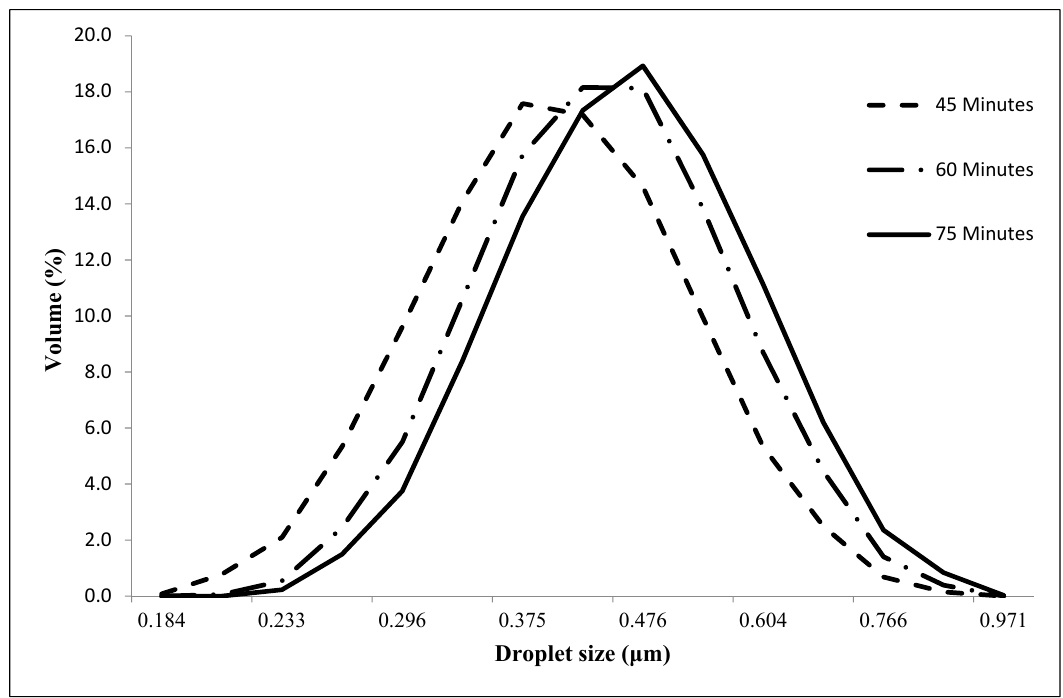
Figure 6. Droplet size distributions of SD.